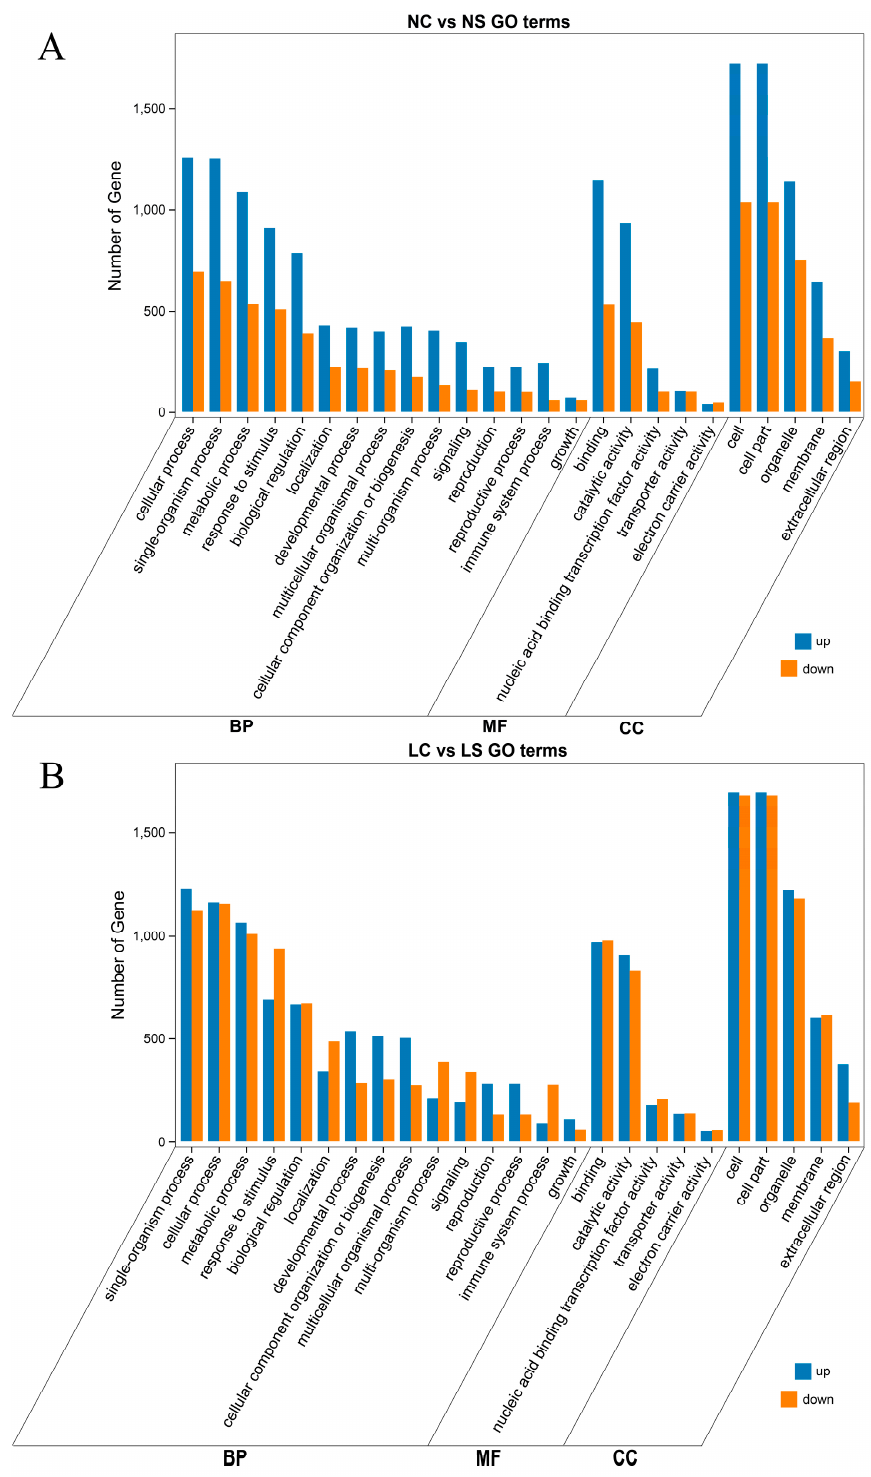
Figure 3. Gene Ontology (GO) Function Enrichment Analysis of DEGs identified. ( A ) GO analysis of DEGs between NC vs NS. ( B ) GO analysis of DEGs between LC vs LS. NS and NC refer to SMV infection and control, respectively, under normal light, while LS and LC refer to SMV infection and control, respectively, in the shade. MF, BP, and CC refer to molecular function, biological process, and cellular